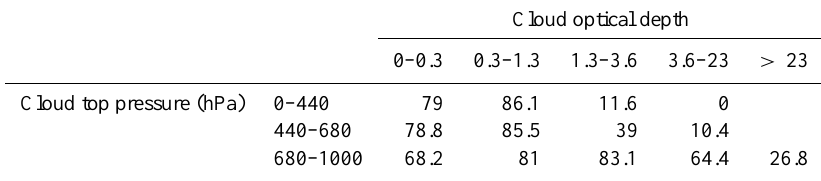
Table 4. Percentage of TES retrievals that were high quality for the C categorization. Overall, 69% of retrievals were high